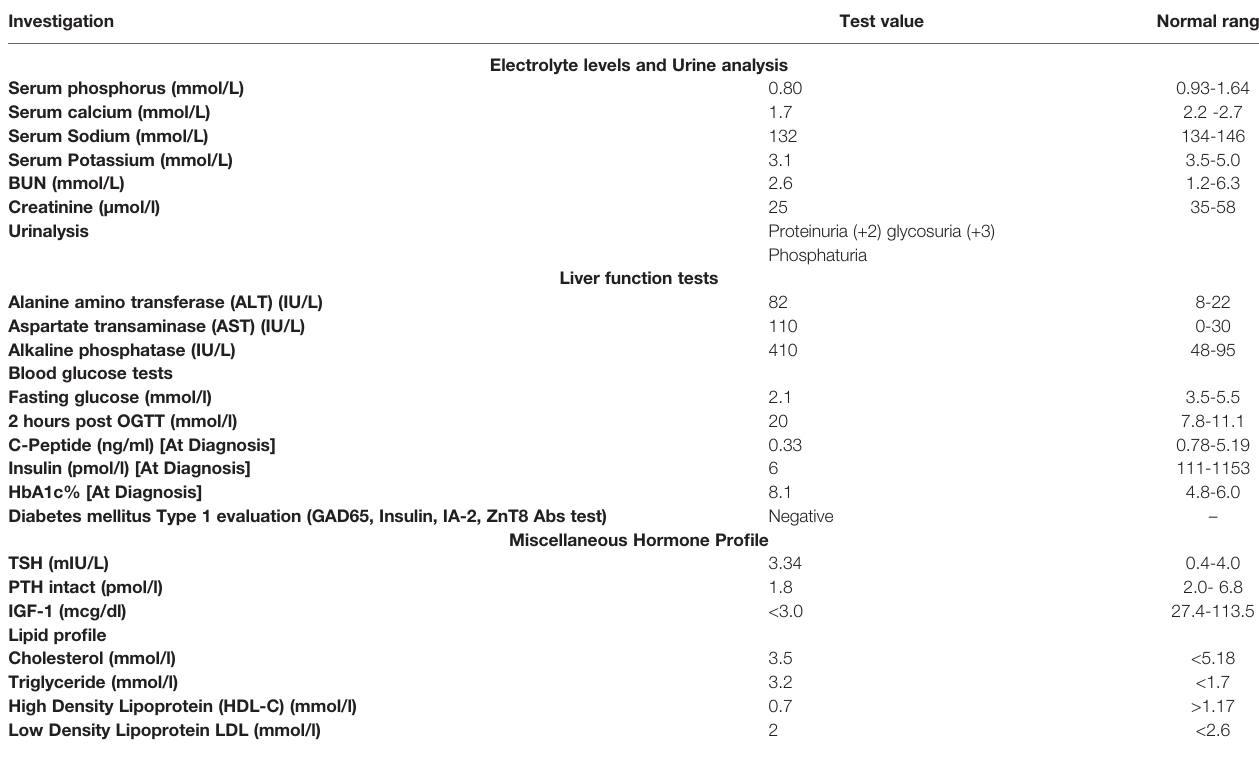
TABLE 1 | Summary of biochemical tests for the